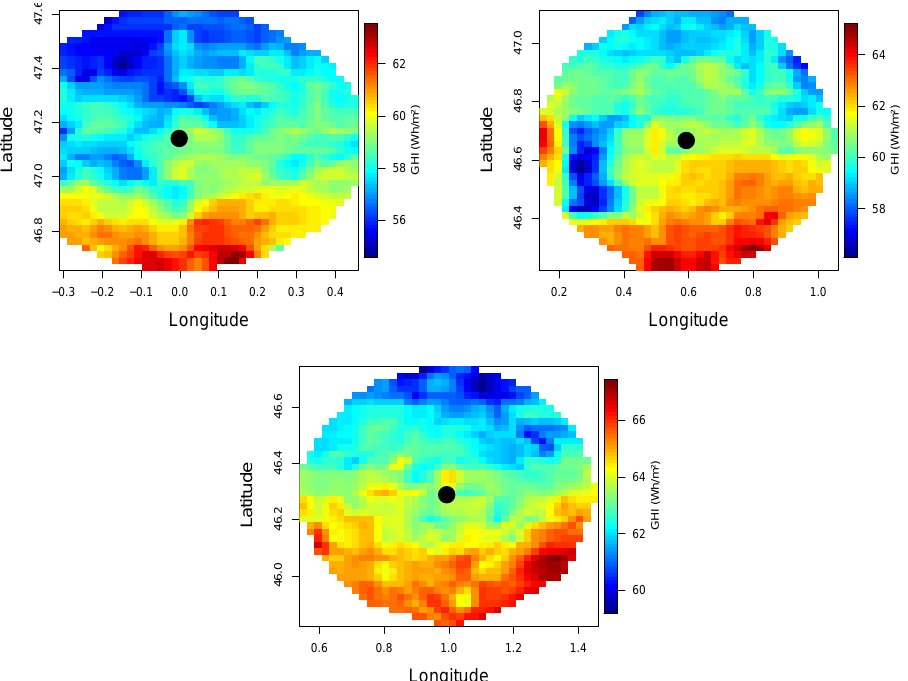
Figure 4. Area of interest around 3 PV power plants of the dataset d . The time is 1 January 2015 at 12:00 UTC. The black dots represent the power plants.